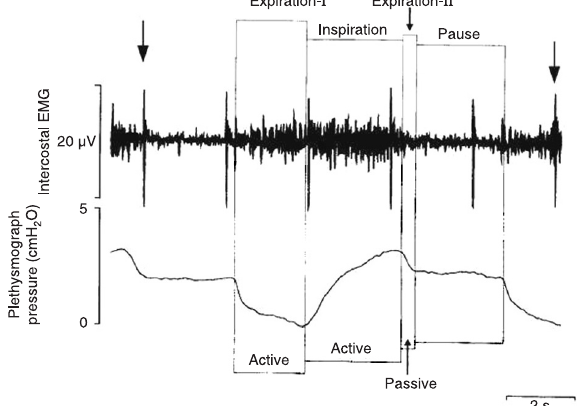
Figure 1. Recording of electromyographic (EMG) activity from intercostal muscles of Uromastyx aegyptius microlepis , together with the pressure generated within a plethysmograph by an as- piratory lung-inflation cycle. The inflation cycle is triphasic, with active expiration-I leading to active inspiration then a brief, pas - sive, partial expiration-II, followed by a ventilatory pause with the lungs inflated, terminated by the next cycle. The recording from intercostal muscles include the ECG (large arrows) (Reproduced from Ref. 59, with permission).